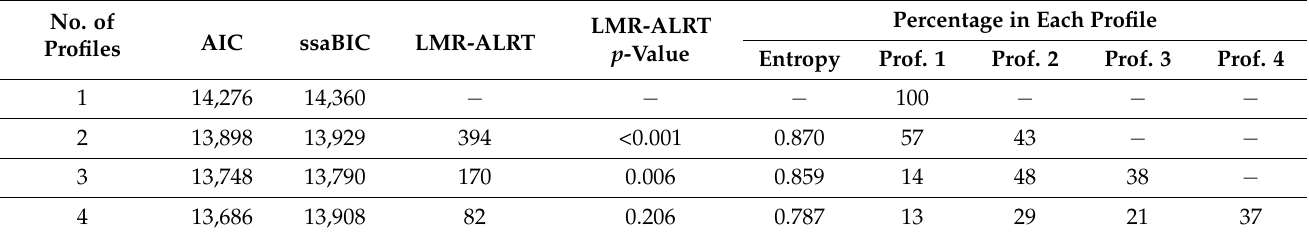
Table 2. Latent profile fit statistics for attribute preference model with one to four profiles.